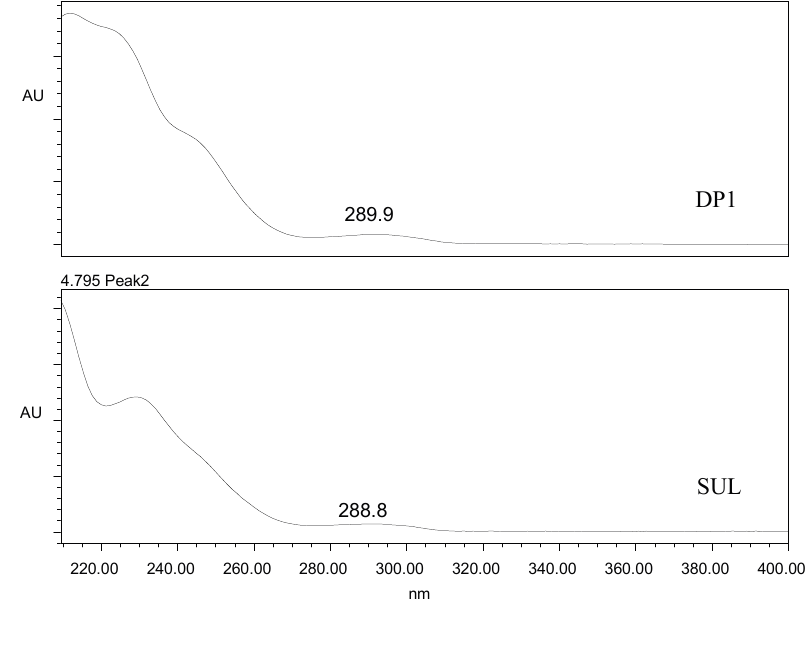
Figure 4. Spectra obtained using the UV/DAD detector in the range from 200 to 400 nm for the peaks relative to the product formed by cleavage of the lactone ring (DP1) and sulfentrazone